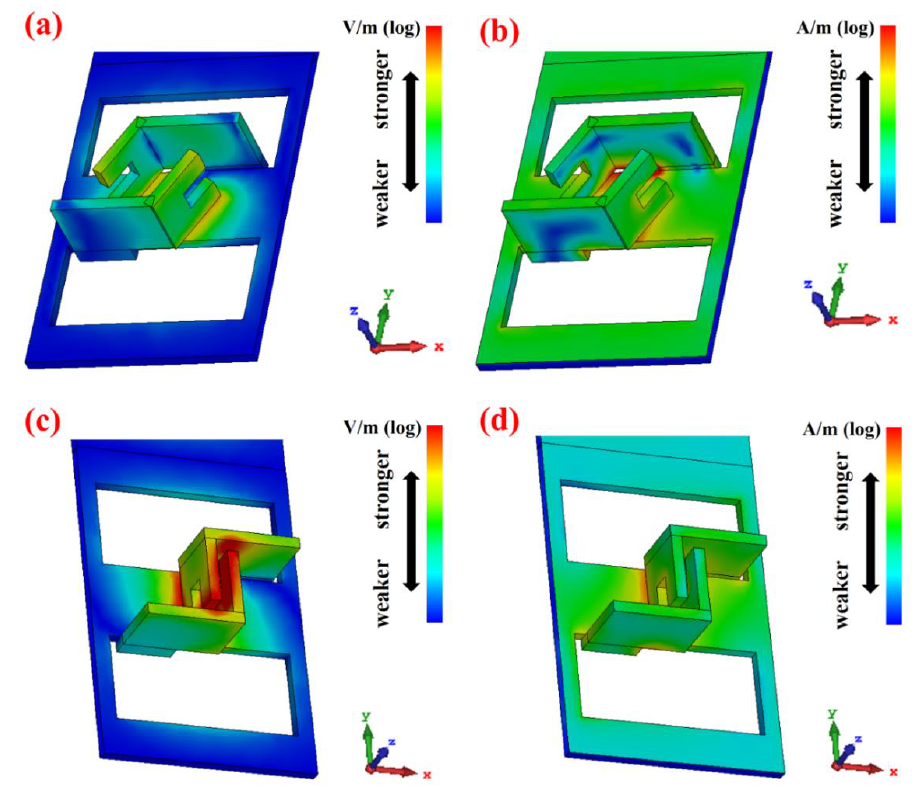
Figure 3. The electric/magnetic field distribution of 3D meta-atom unit cells with different claw gap distance. ( a ) Electric field and ( b ) magnetic field distribution simulation results of the 3D meta-atom array with larger claw gap, ( c ) electric field and ( d ) magnetic field distribution simulation results of the 3D meta-atom array with smaller claw gap.